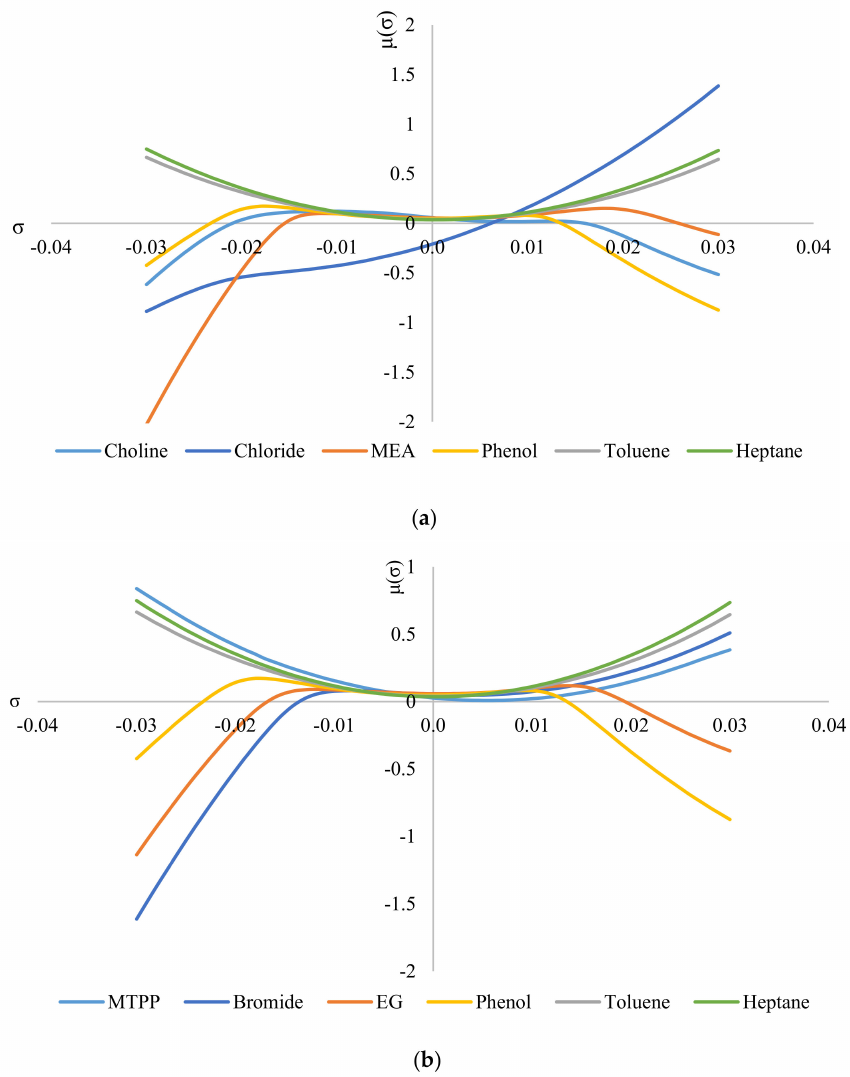
Figure 6. σ − potentials of species in the phenol − containing systems: ( a ) systems containing the DES ChCl:MEA, and ( b ) systems containing the DES